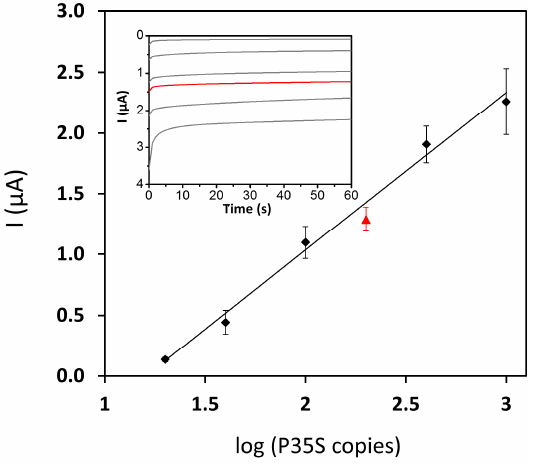
Figure 3. Analytical response in absolute value of the PCR-electrochemical genosensor method for MON810 maize: (black dots) calibration plot obtained by dilution of certified MON810-10% with MON810-0%; (red triangle) reference material MON810-2%. Inset: chronoamperograms corresponding to the data displayed in the calibration plot.